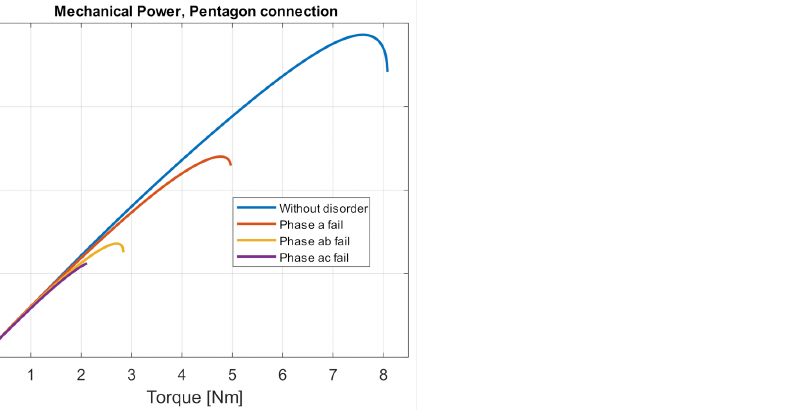
Figure 12. Power on the shaft from the load moment, pentagon connection, U IN = 5 × 230 V, 50 Hz.